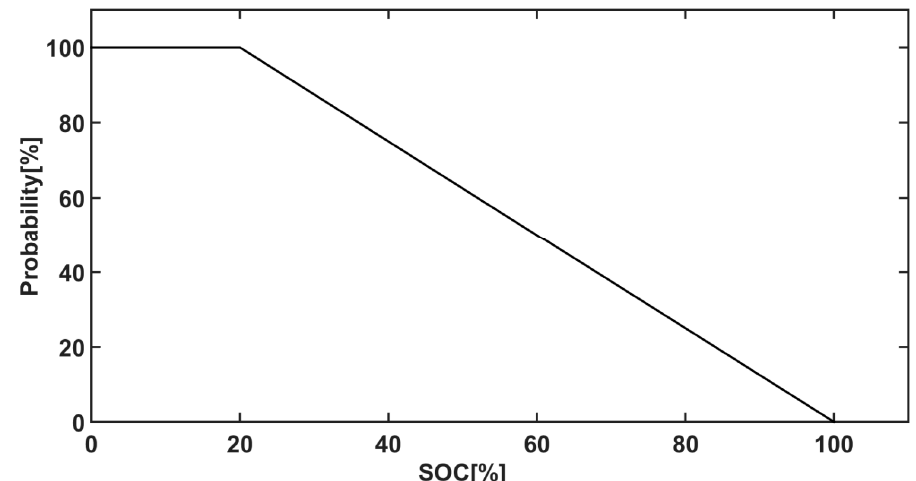
Figure A1. Probability that an EV is charged ( p CH ) with SOC limit = 0.2 and A = 1.25.